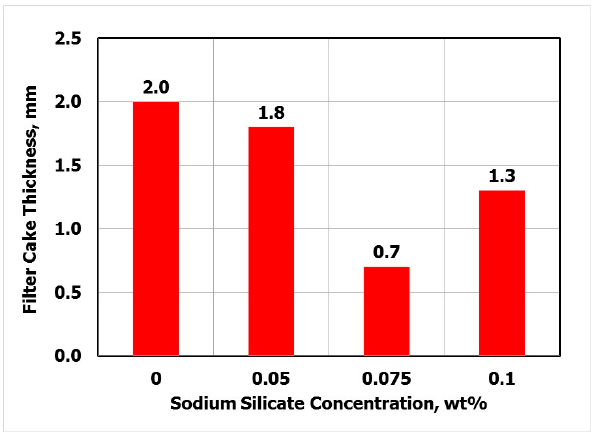
Figure 7. Effect of adding sodium silicate on filter cake thickness.